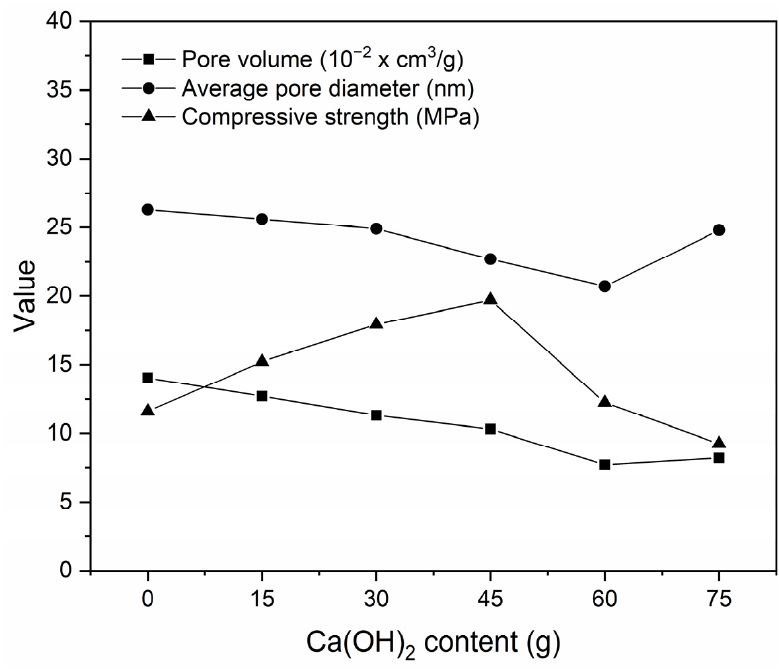
Figure 7. Pore volume, average pore diameter, and compressive strength of materials prepared by using 8 M NaOH and different Ca(OH) 2 contents.